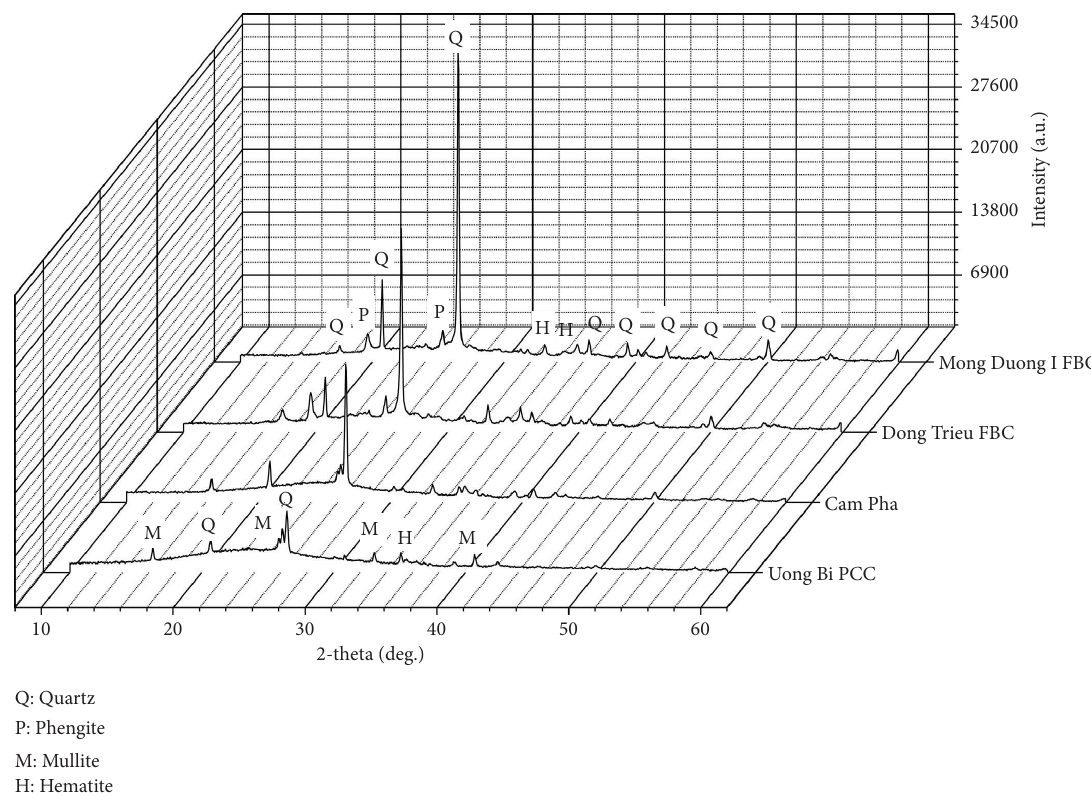
Figure 3: Te X-ray difraction patterns of fy ash